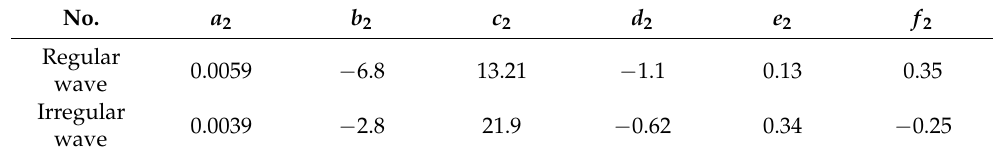
Figure 24. Scatter diagrams of the measured and predicted wave forces for the vertical and sloped seawalls: ( a ) regular wave; ( b ) irregular wave. Table 4. Empirical coefficients for predicting the mean wave overtopping discharge over the seawall.